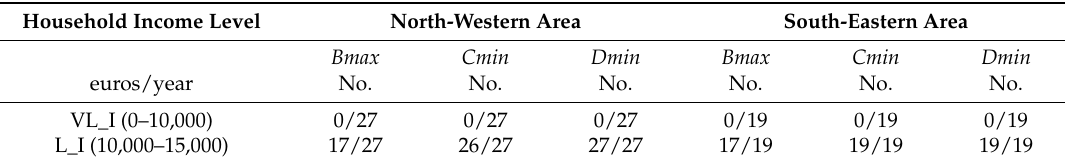
Table 8. Combined income approach. Frequency of housing affordability per income level and per zone in the NWS and SWS